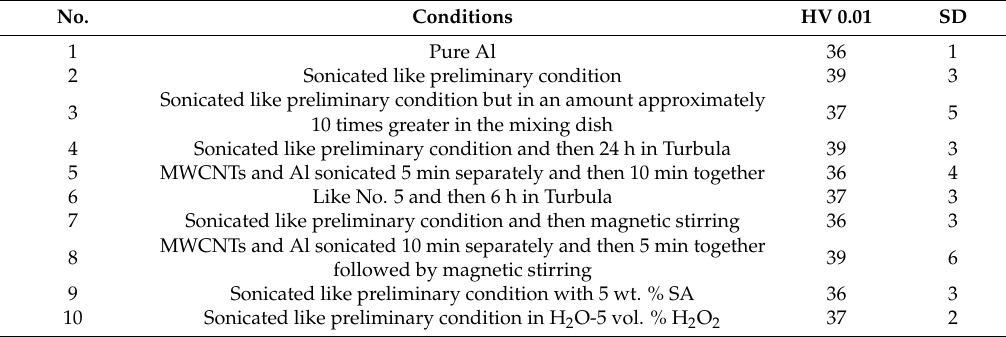
Table 3. Microhardness values specimens, 0.75 wt. % MWCNT, compacted at ~400 MPa and